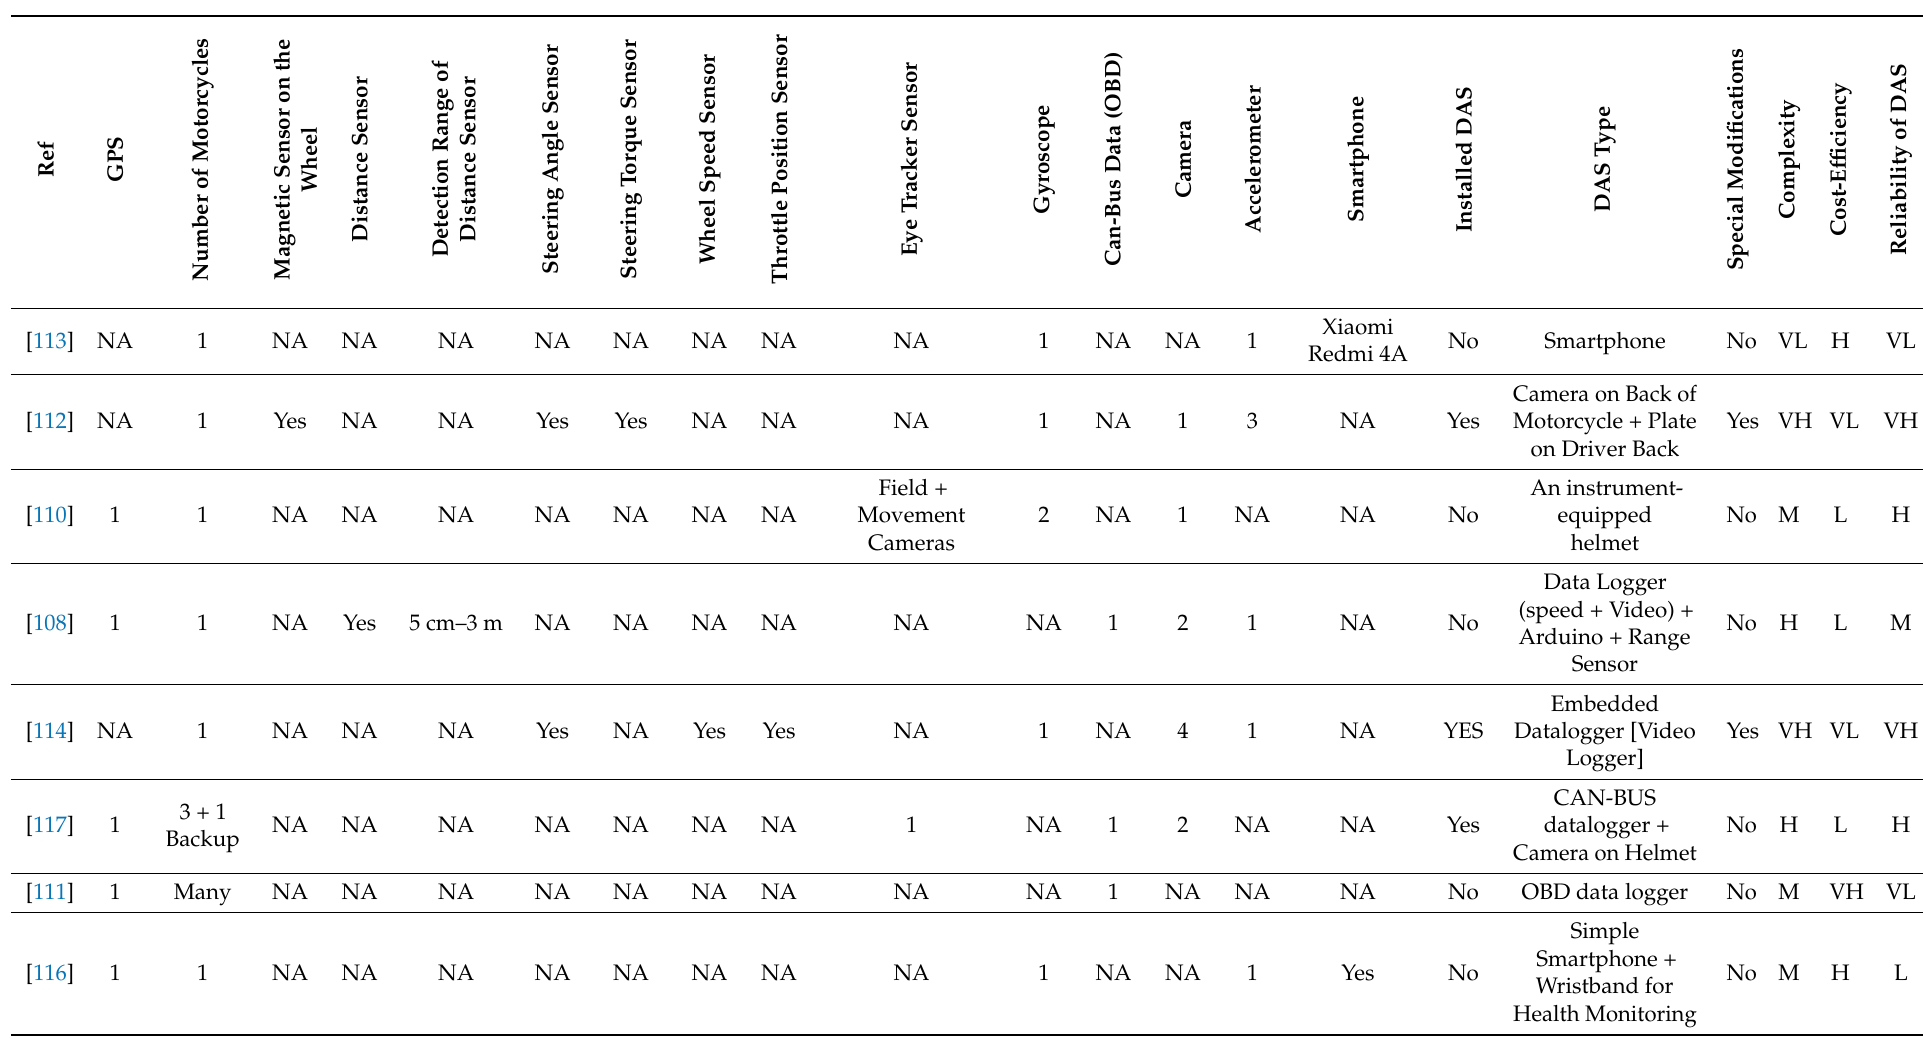
Table 8. Sensors used in real-time motorcycle driver behaviour